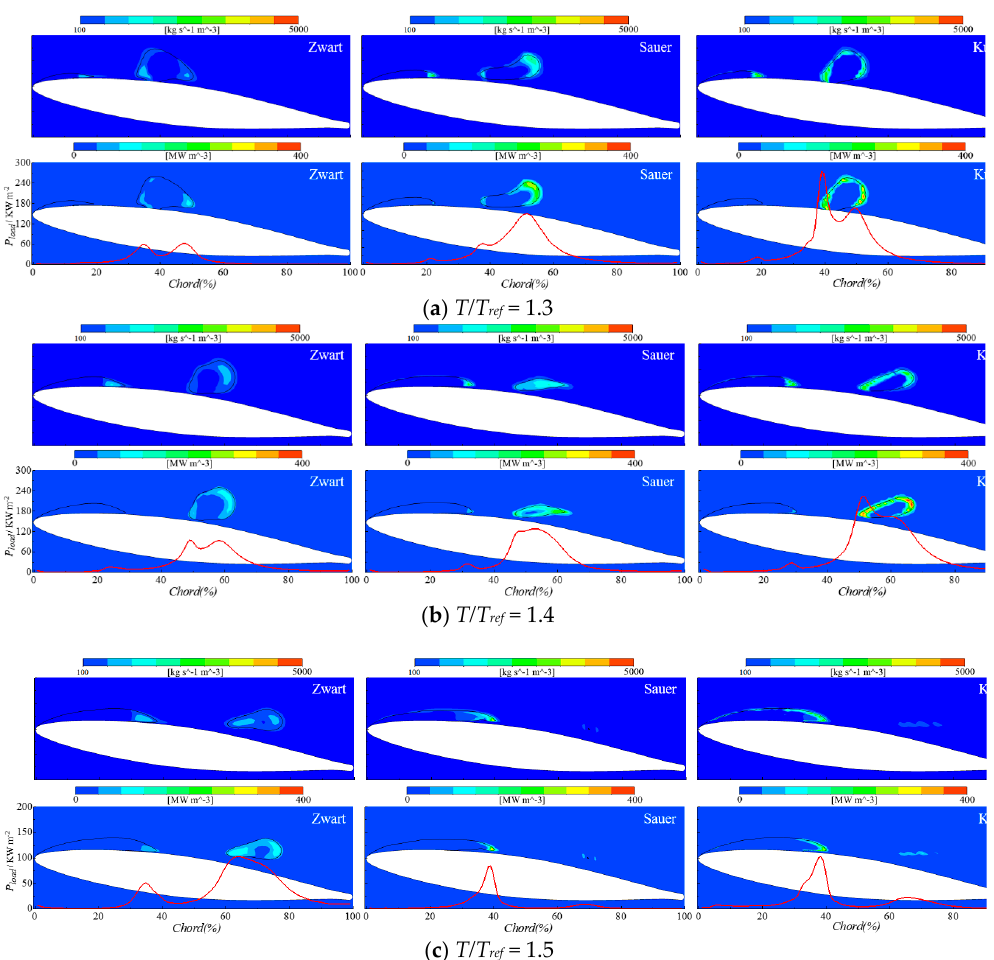
Figure 10. Results obtained with the Zwart (left), Sauer (middle) and Kunz (right) models at different instants comprising contours of m from vapor to water ( top ) and of P den , and value of P load on the